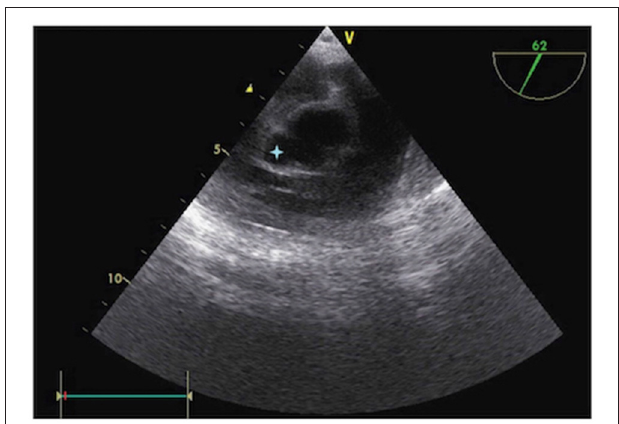
FIGURE 2 | Preoperative transesophageal echocardiography (TEE) showing a para-aortic abscess (